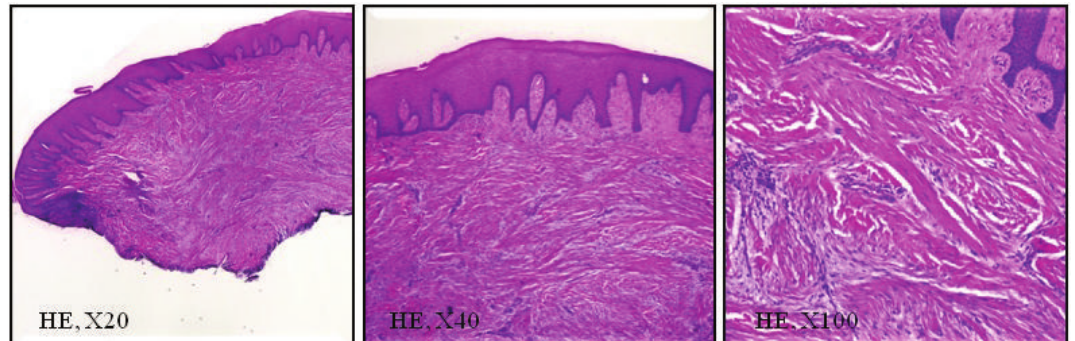
Figure 5: Histopathological sections of the excised lesion with different magnification.